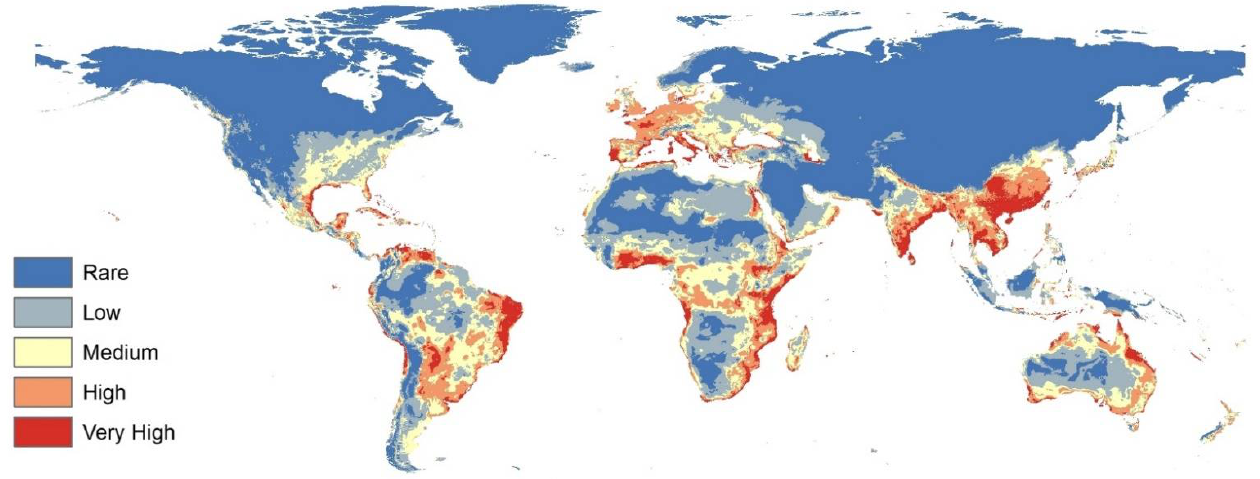
Figure 2. Current global prediction of habitat suitability for A . niger . Figure 2 . Current global prediction of habitat suitability for A . niger .